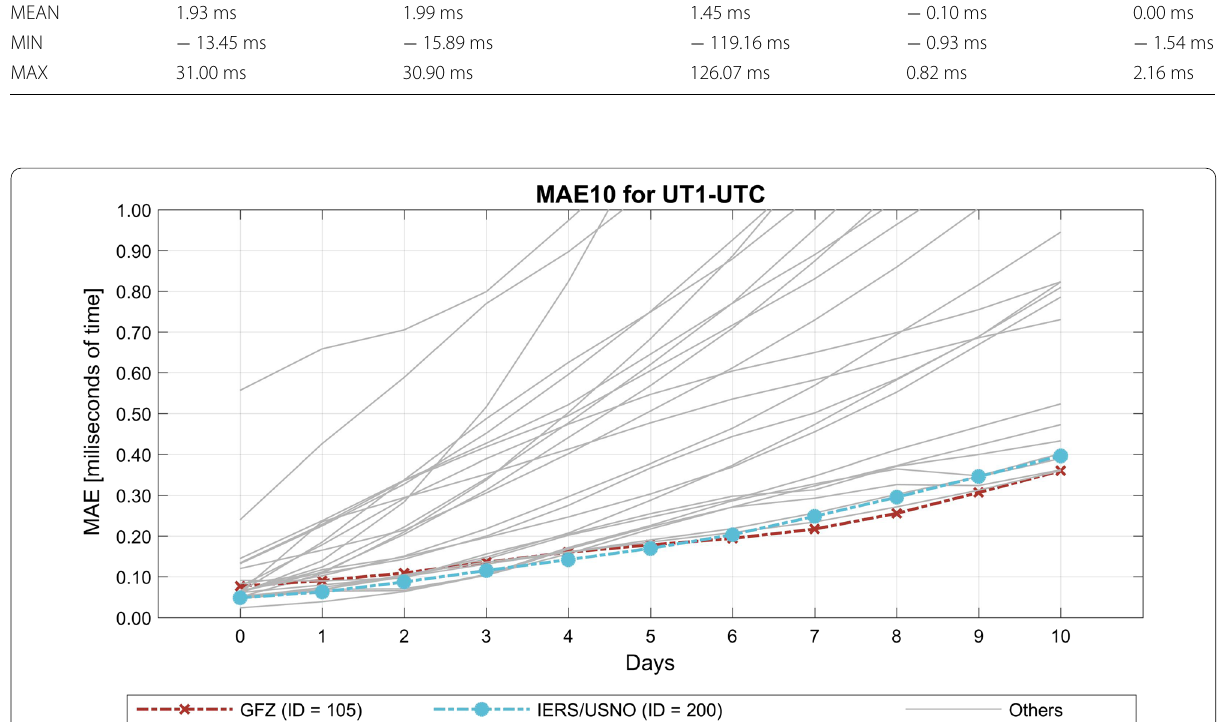
Fig. 1 Mean absolute error (MAE) for UT1-UTC predictions from GFZ (ID participants for forecast horizons between 0 and 10